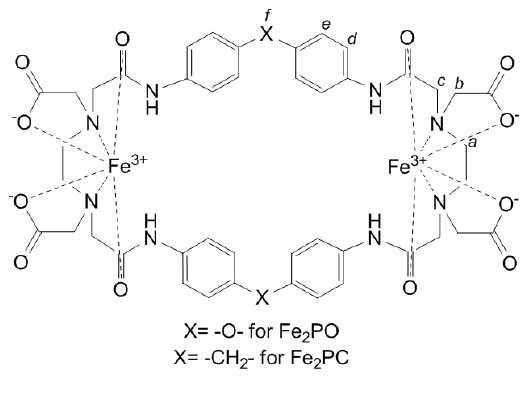
PO and Fe PC cyclophane iron (III) complexes. 2 2